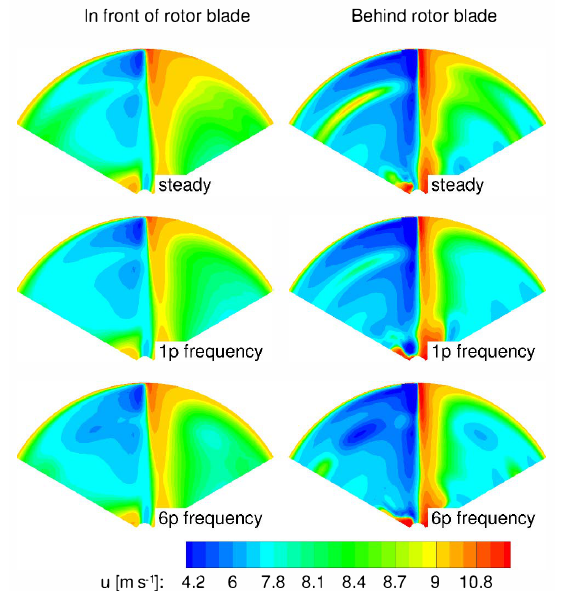
Figure 16. Flow field extracted at one local chord distance in front of and behind the rotor blade for β = − 10 ◦ .